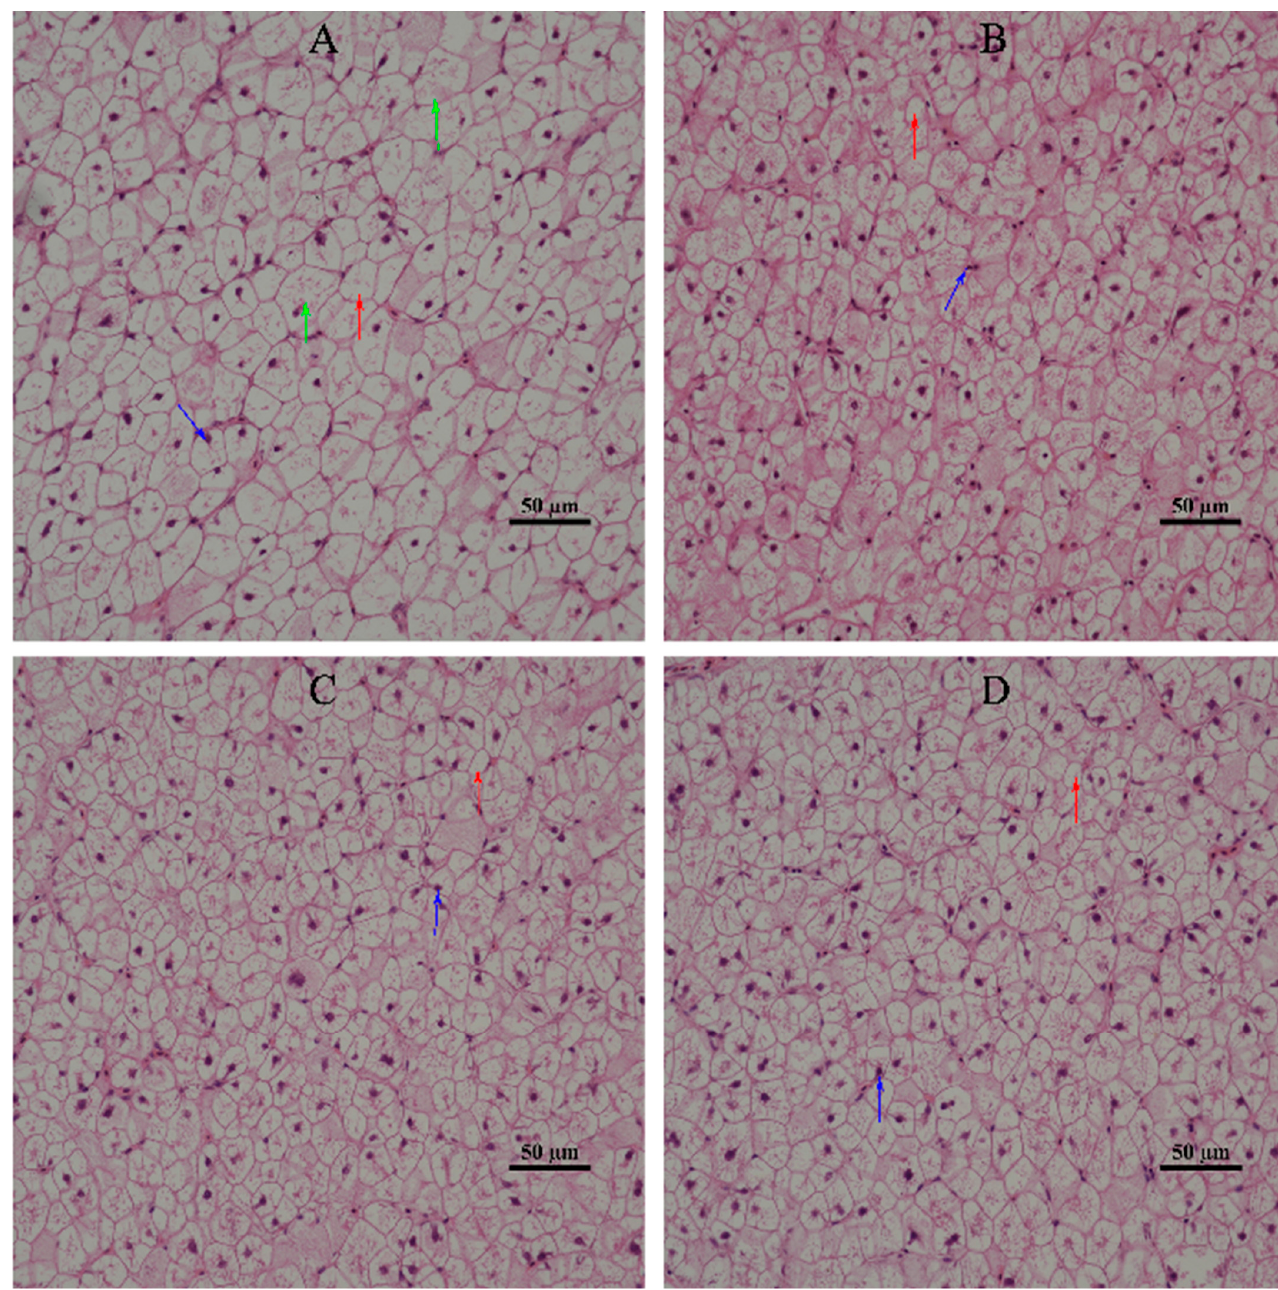
Figure 1. Effect of diet supplementation with α -LA on the hepatic histomorphology of juvenile hybrid groupers. The labels in the upper right corner represent the different experimental diets. ( A ) SL0; ( B ) L1; ( C ) L2; ( D ) L3. The red arrow represents cell vacuolation, the blue arrow represents cell nuclear migration, and the green arrow represents cell swelling. Scale bars = 50 μ m; 400× magnification.